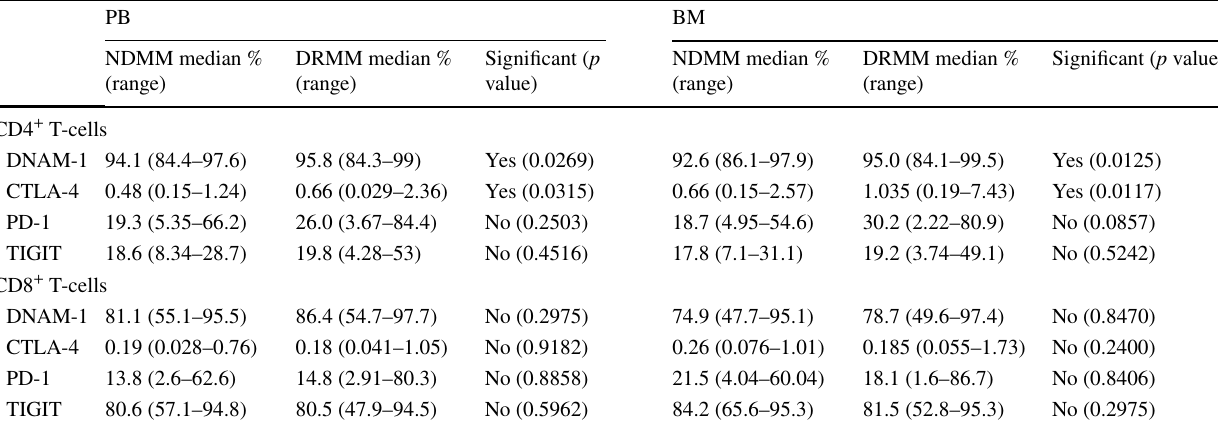
Table 2 Distribution of immune checkpoint receptors on CD4 + and CD8 + T cells in BM and PB of myeloma patients